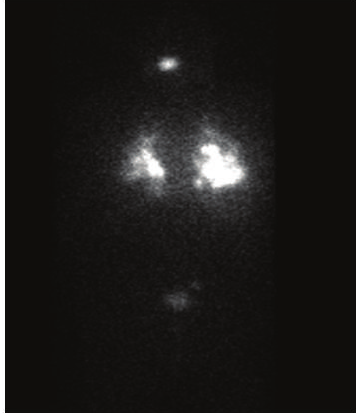
Figure 4: Unstimulated I-131 scan on March 28, 2012.